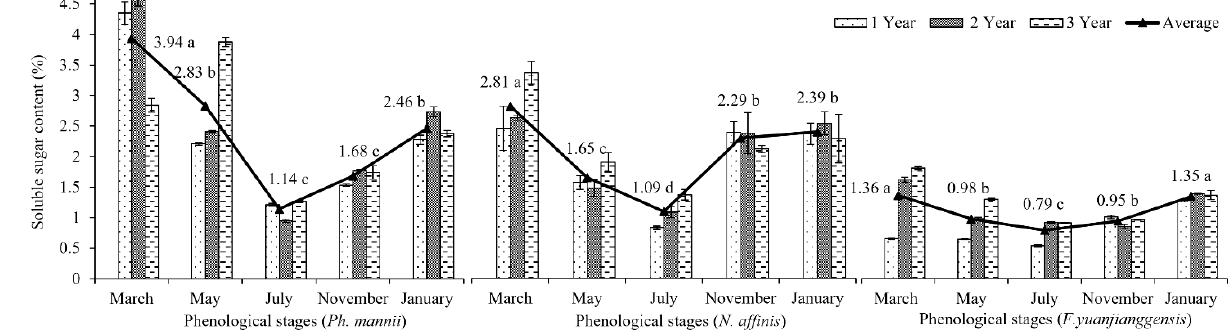
Figure 4. Dynamic changes in the soluble sugar contents of three bamboo types at different pheno- logical stages.